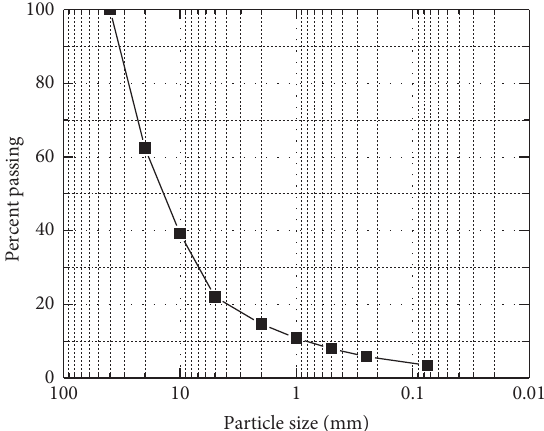
Figure 9: The gradation curve of soil-rock